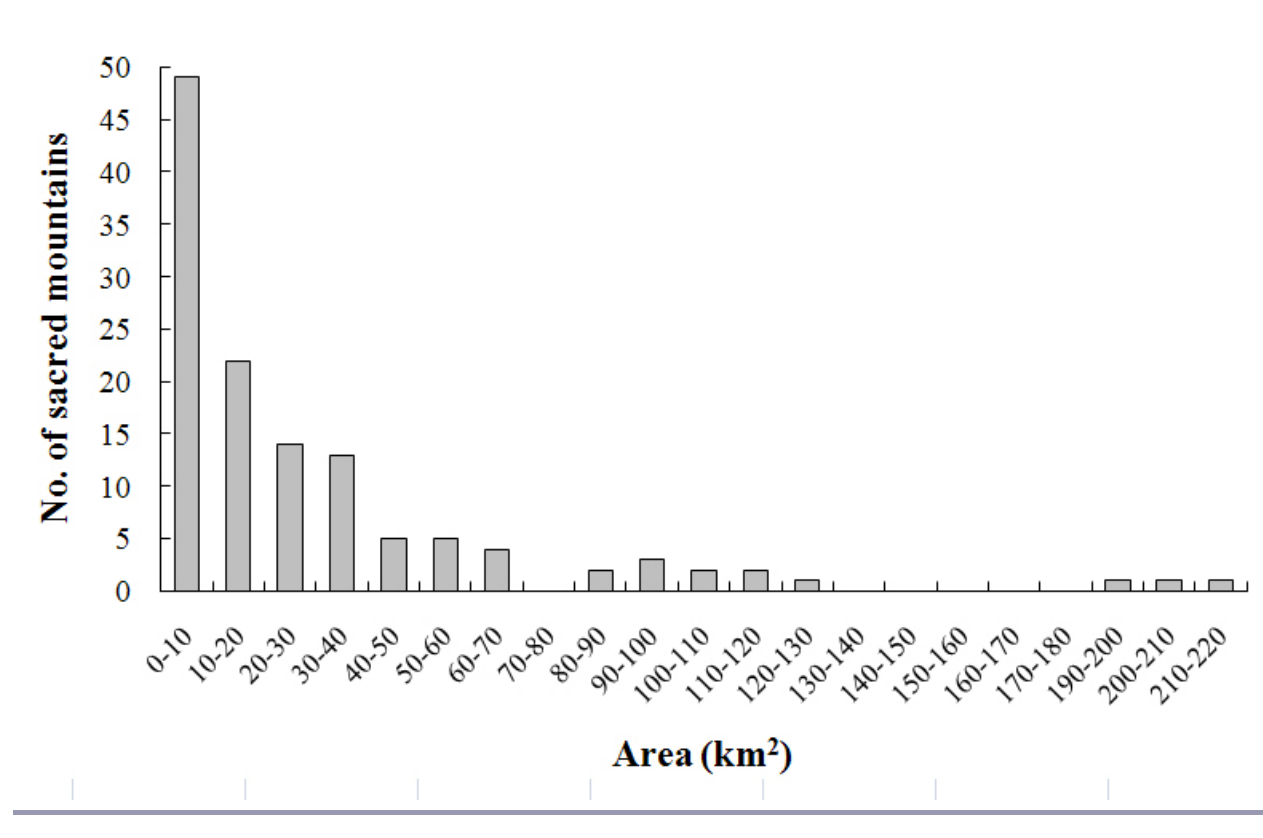
Fig. 3 . Extent of the land area of Tibetan sacred mountains (n = 150) in the six sampled counties in Ganzi Prefecture, Sichuan Province,